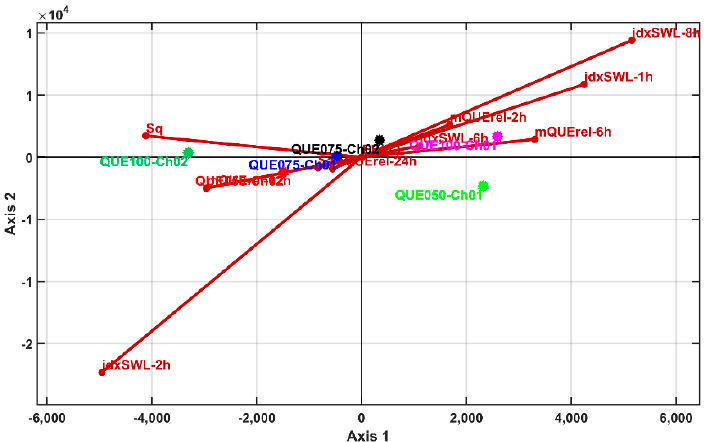
Figure 20. Biplots of LDA results in 2D representation for Axis1 and Axis2 canonical components.